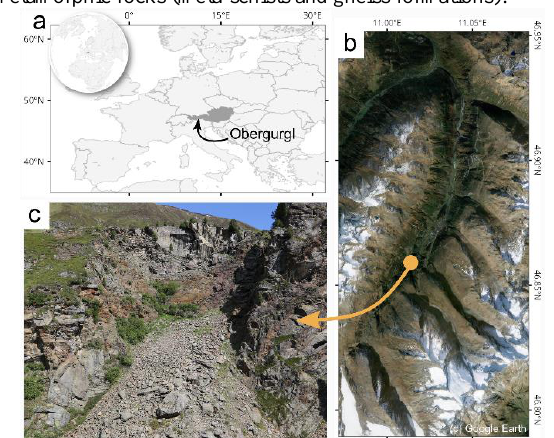
Figure 1. Schematic view of the investigation site in Obergurgl, Austria.